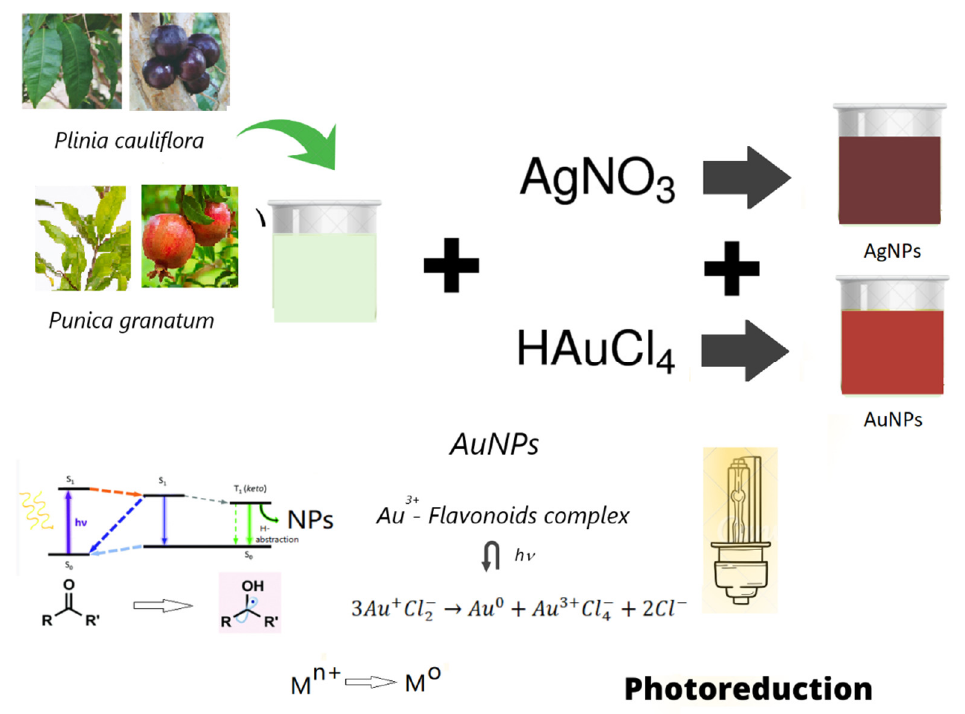
Figure 1. Experimental procedure. Preparation of the Pc and Pg extracts of leaves and fruits, adding AgNO 3 or HAuCl 4 in solutions. Intermolecular photoreduction of polyphenol ketones and ketyl Radical Generation. These radicals reduce metal ions to generate metal nanoparticles.